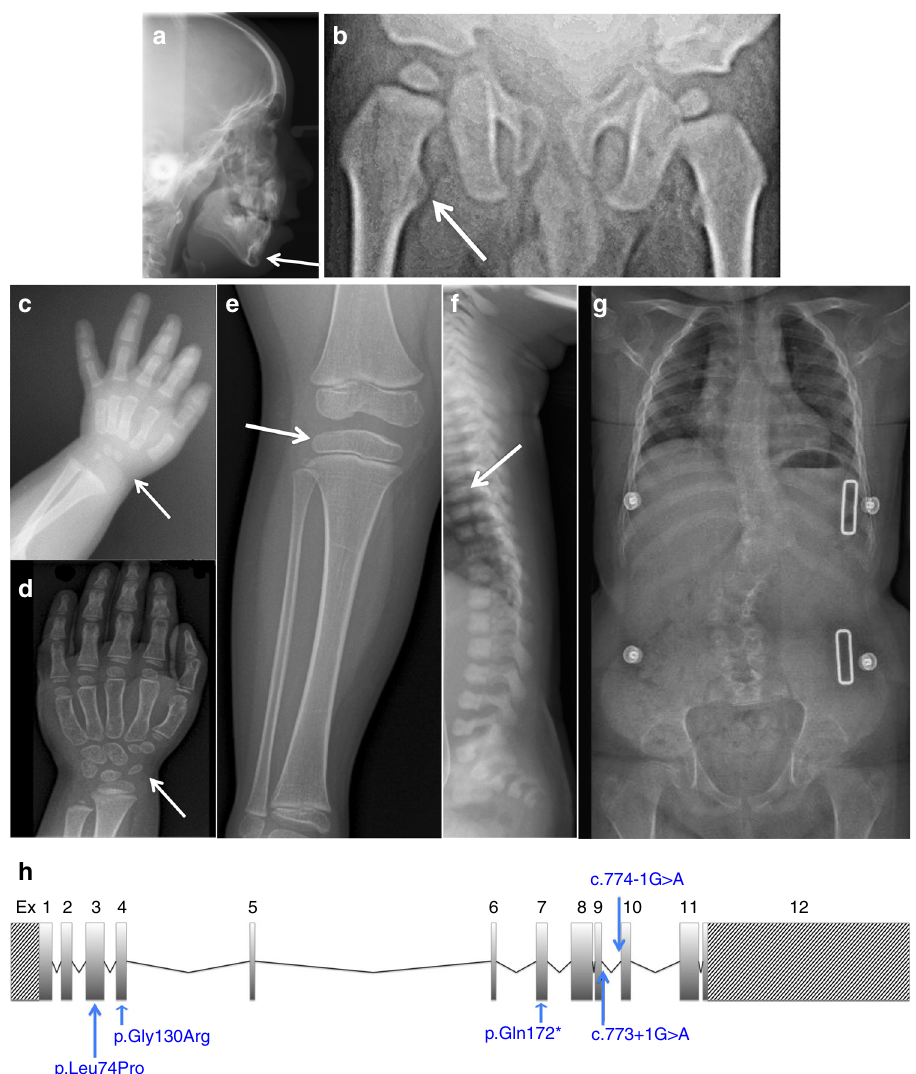
Fig. 1 Morphological and skeletal features of SLC10A7 -de fi cient patients. a Skull X-ray at 6 years of age (Patient 5). Note the retrognathia (arrow). b Hip at one year of age (Patient 1). Note the Swedish key appearance of the proximal femur (medial beak and exaggerated trochanters, arrow). c Hand X-rays at 6 months of age (Patient 2). d Hand X-rays at 3 years of age (Patient 3). Note in ( c ) and ( d , the advanced carpal ossi fi cation (presence of three ossi fi ed carpal centres at 6 months and seven ossi fi ed carpal centres at 3 years instead of one and three, respectively, see arrows). e Knee at 3 years 9 months of age (Patient 3). Note the genu valgum (angled in knee) and fl at epiphyses (arrow). f Spine X-rays at 1 month of age (Patient 1). Note the coronal clefts and irregular shape of vertebrae (arrow). g Spine and hip X-rays at 9 years of age (Patient 4). Note the kyphoscoliosis. Informed consent for publication of images was obtained from all individuals or the legal guardians of minors. h Localization of the fi ve SLC10A7 mutations relative to the SLC10A7 gene organization (striped rectangles indicate the 5 ′ and 3 ′